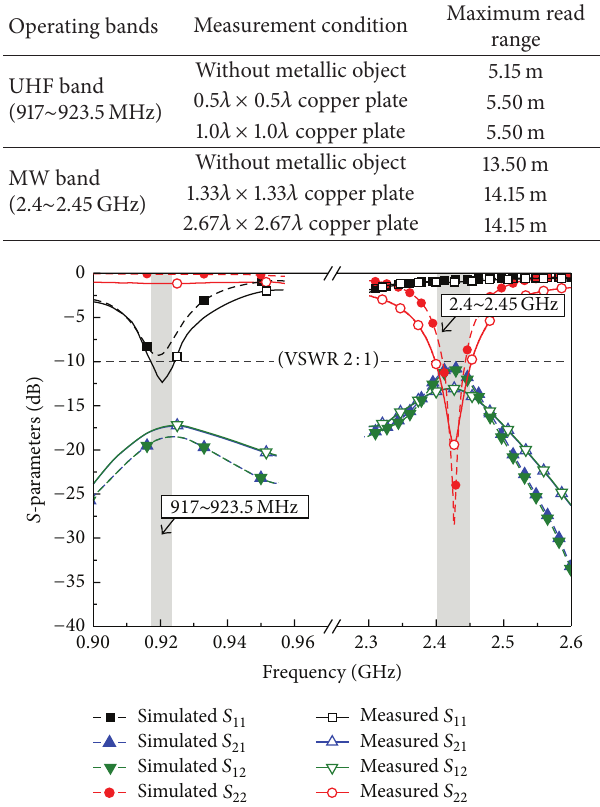
Figure 5: S -parameter of the proposed antenna without metallic objects.